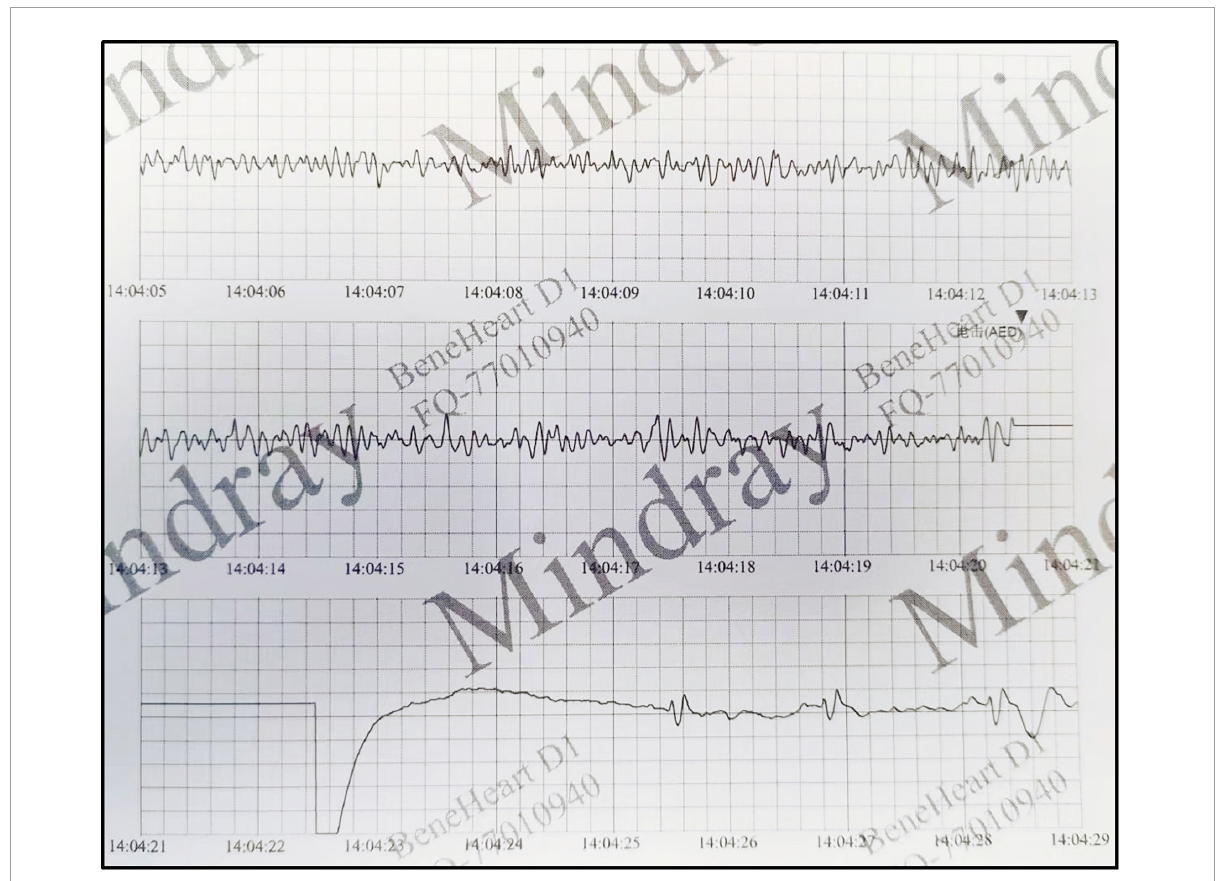
FIGURE2 The ECG at the time of the AED discharge indicated ventricular fibrillation.